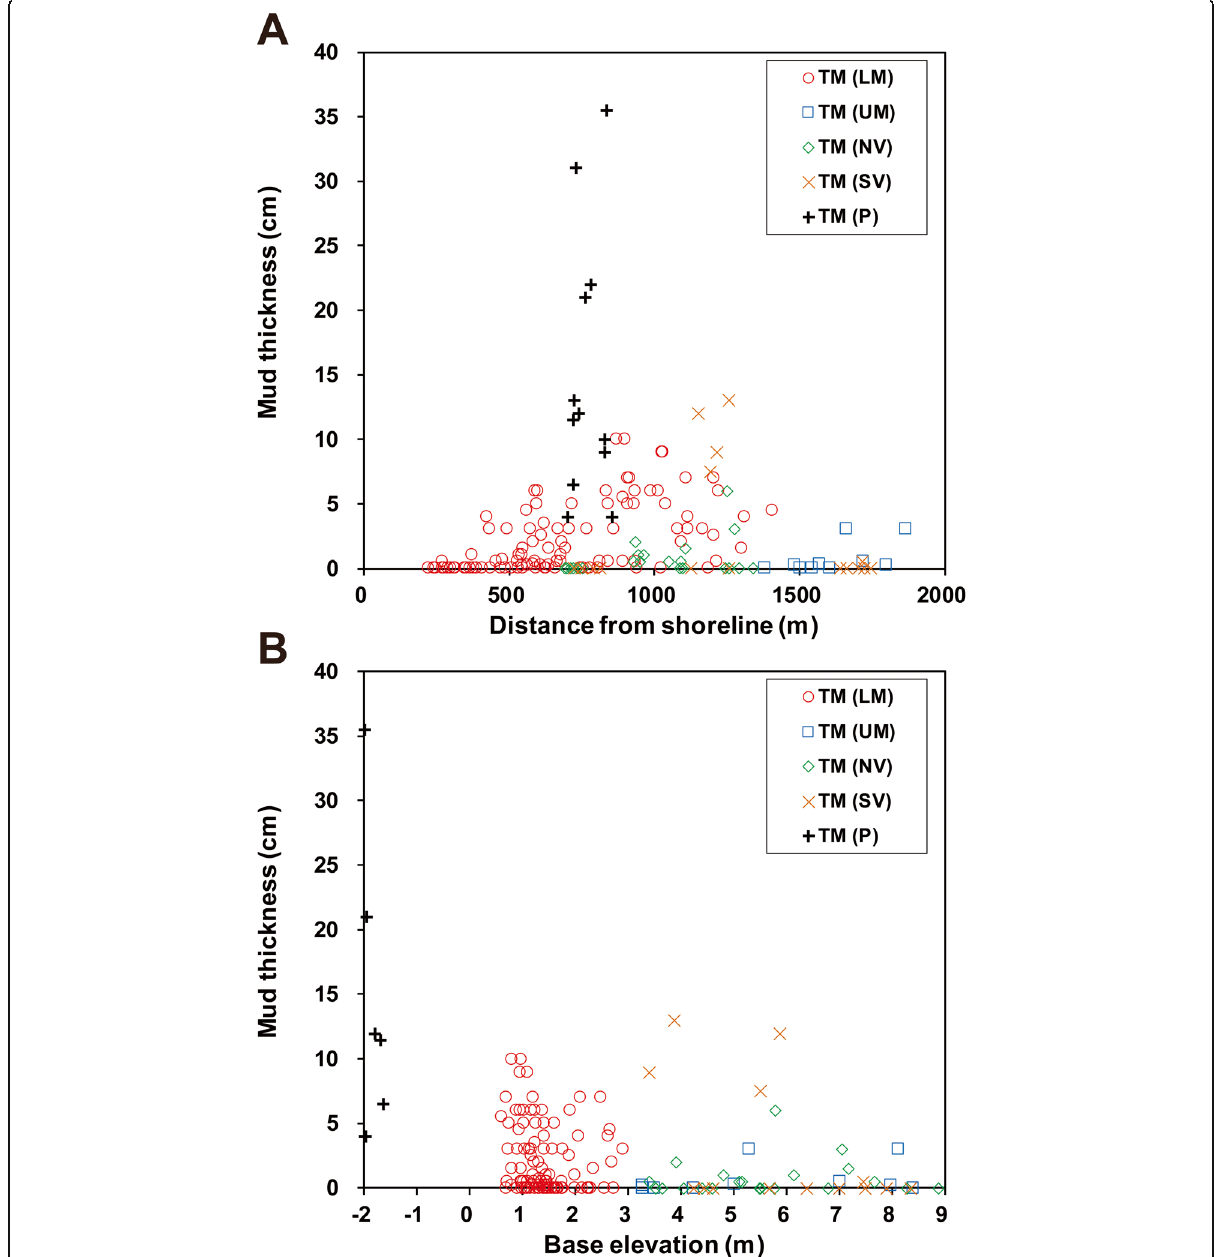
Fig. 5 Thicknesses of tsunami mud shown by each topographic type against the inland distance from the shoreline ( a ) and the base elevation ( b ). Base elevation means the elevation (above T.P.) of the bottom of tsunami deposit. TM, tsunami mud layer; LM, lower main valley; UM, upper main valley; NV, north sub-valley; SV, south sub-valley; P,